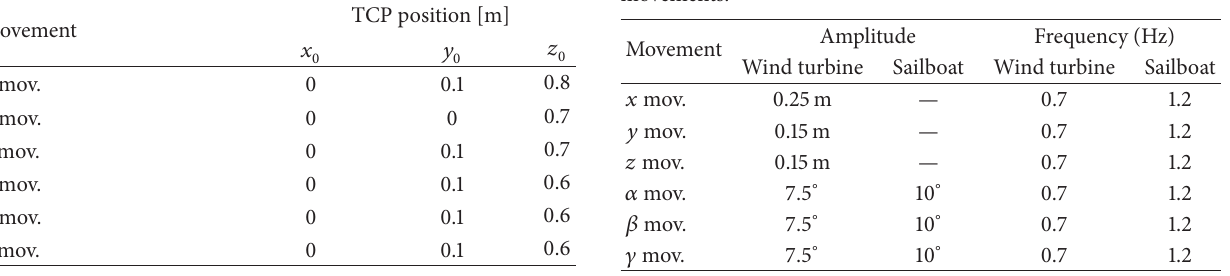
Table 2: Maximum amplitudes and frequencies of the desired